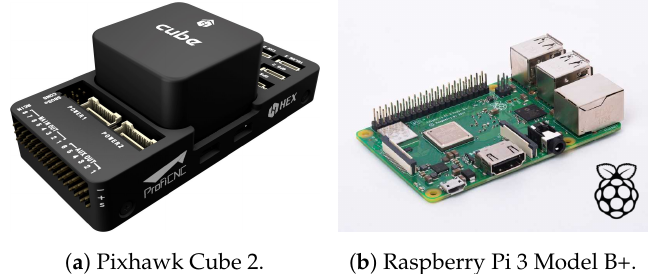
Figure 1. Hardware to implement guidance and formation control